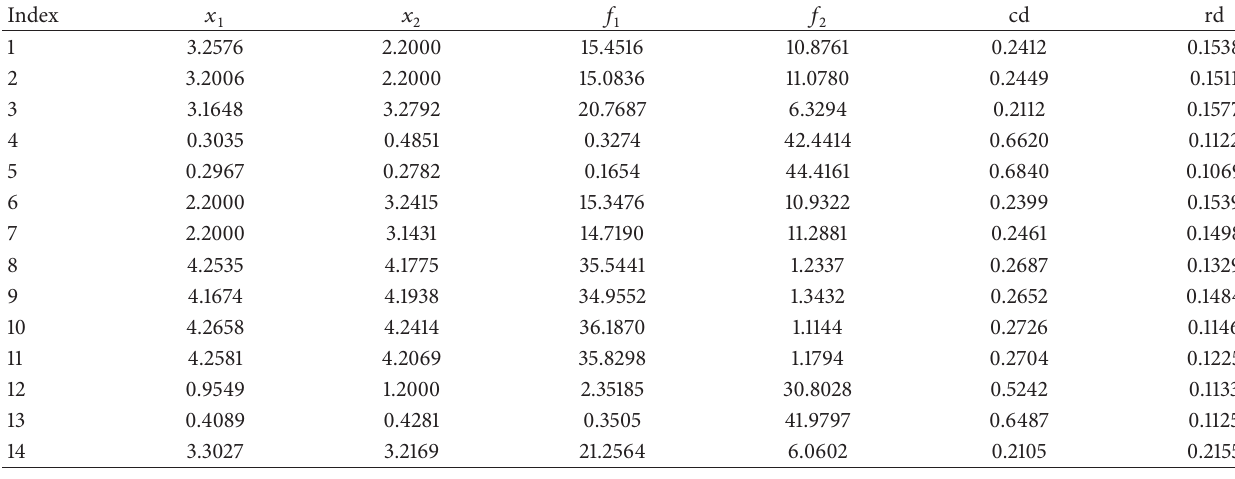
Table 2: The decision variables, objective functions, and consensus and robustness measures of the final selected nondominated solutions for M-BINH.